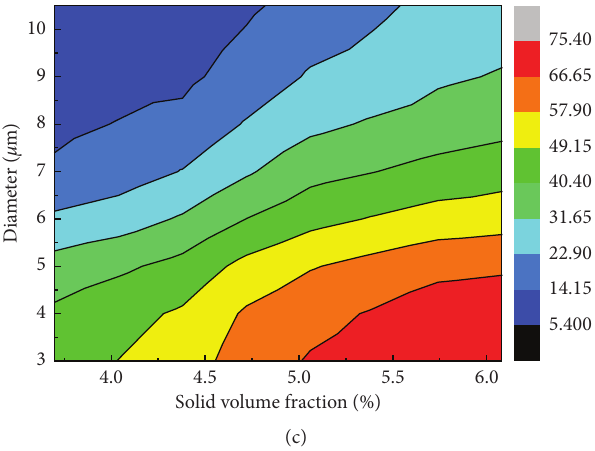
Figure 13: Strength under the coupling of different SVFs and fiber diameters: (a) compressive strength; (b) tensile strength; (c) shear